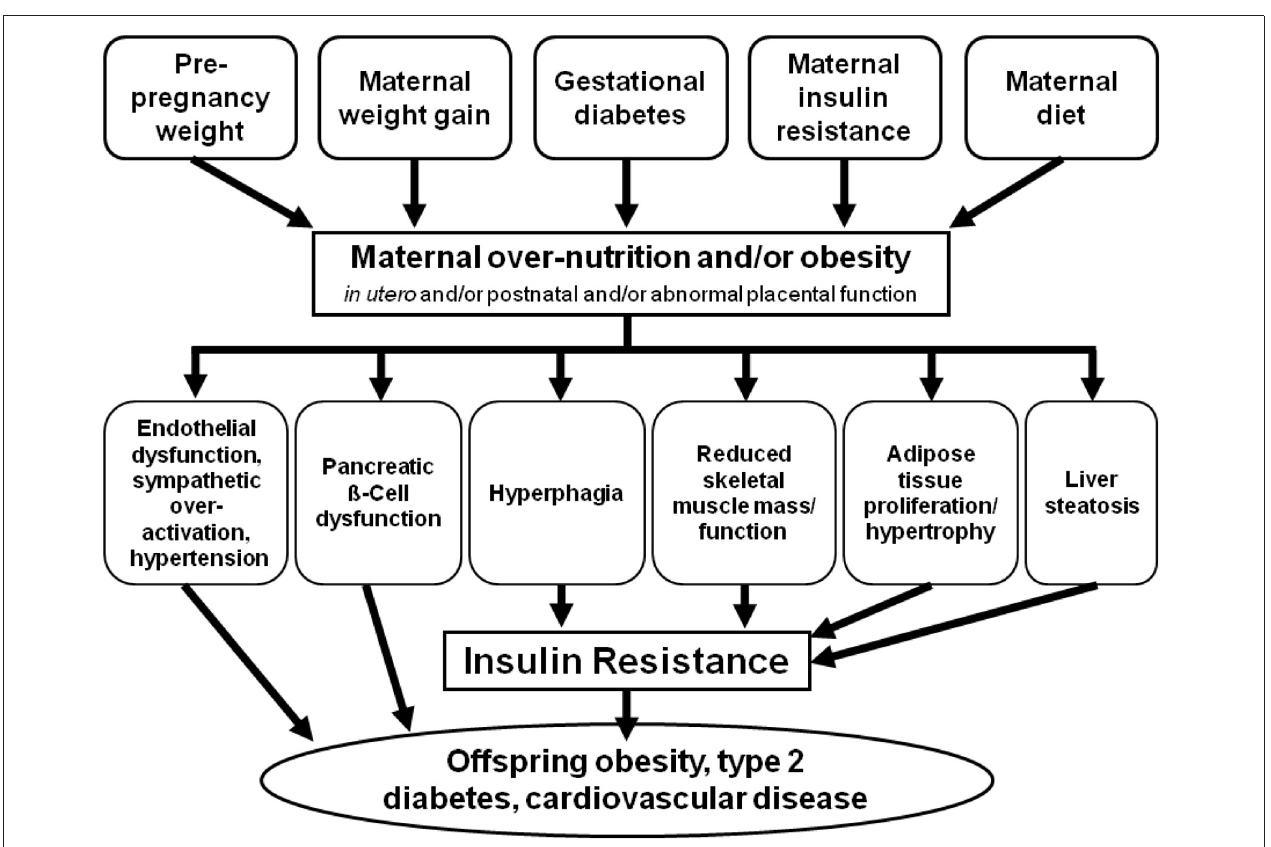
FIGURE 1 | Common mechanistic pathways of developmental programming as a result of maternal over-nutrition and obesity.